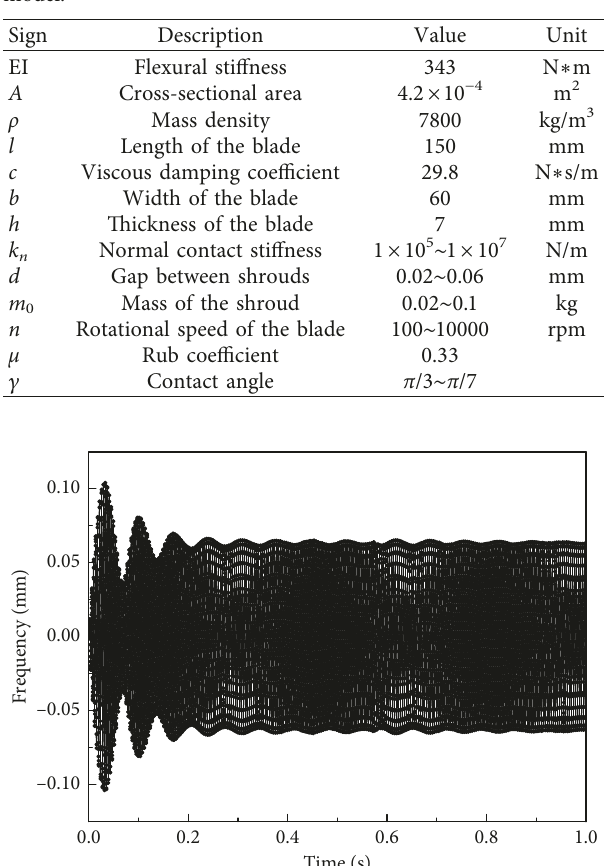
Table 1: Material constants and geometrical parameters for the model.